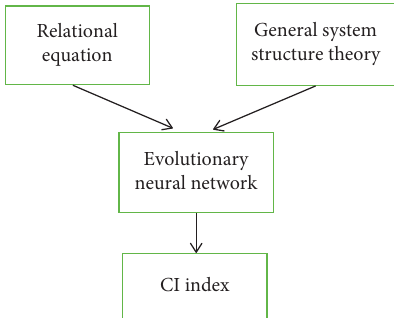
Figure 3: Logical relationship diagram of each theoretical